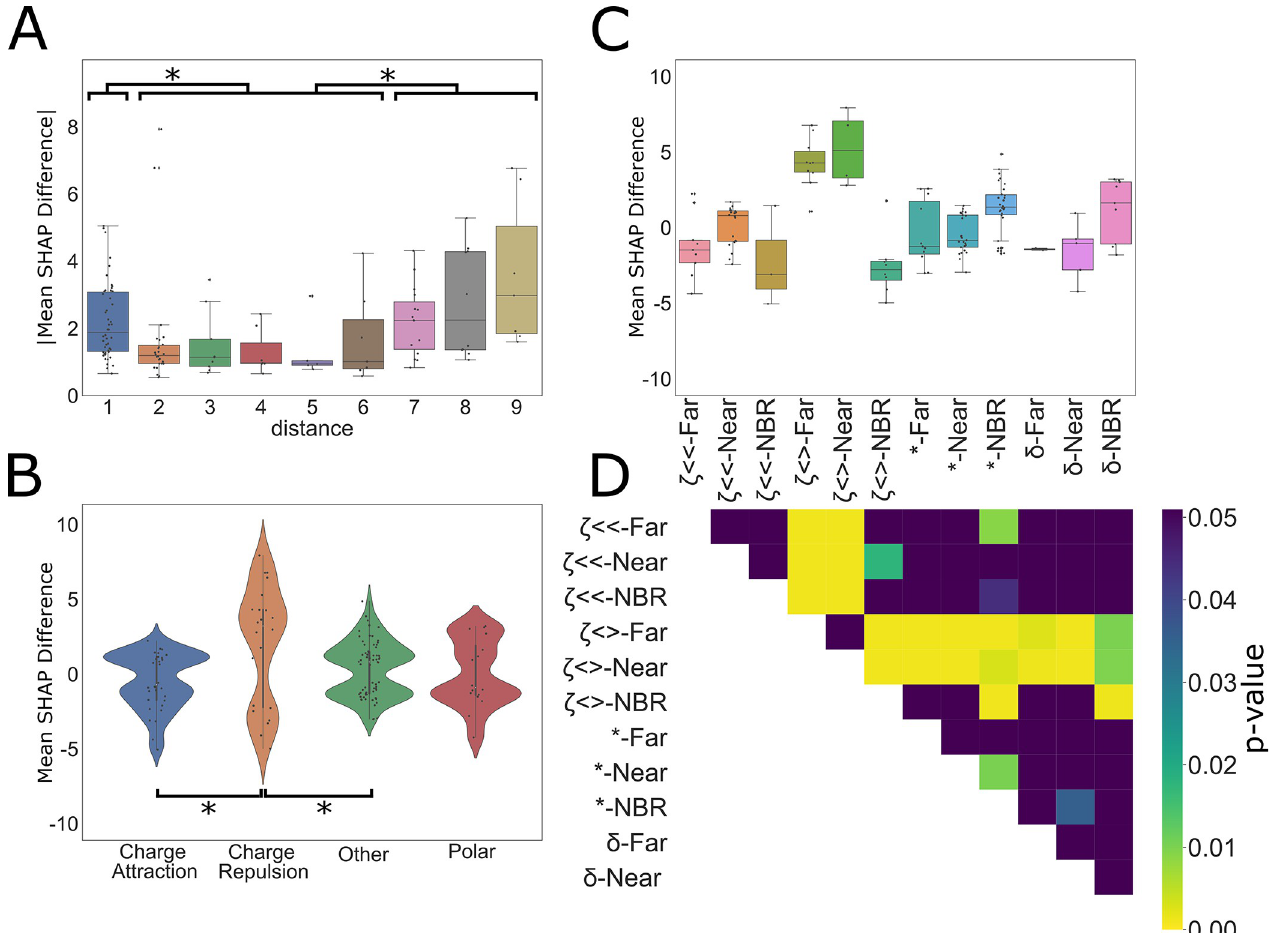
Fig 7. Dependence analysis of CCS model. (A) Significant (Bonferroni corr. P-value < 0.05) values were taken from the interpositional dependence analysis and the difference in the mean between the interdependent amino acids SHAP values and the remaining amino acids at each compared position pair were grouped based on the distance between the dependent interaction, (B) the category of interaction, or (C) distance and interaction category. Categories are labelled by the following for the combined bar plot and heatmap: z << = charge attraction, z <> = charge repulsion, � = other, and δ = polar. For the distance analysis, interactions were grouped into three categories, neighboring (distance = 1), near (distance = 2, 3, 4, 5,6), and far (distance = 7, 8, 9). � indicates significance (ANOVA with Tukey’s post hoc test p-value < 0.05). For the interaction categories in (B) and (C), each interaction was grouped by the expected type of interaction between the two amino acids. Significant differences between interaction types are noted by the pairing by lines (ANOVA with Tukey’s post hoc test p-value < 0.05). (D) Significant differences between combined categories are illustrated by the heatmap where significant values (ANOVA with Tukey’s post hoc test p-value < 0.05) are designated by colors other than purple. Exact p-values for each are provided in S4 Table. repulsive molecular interactions, including charge repulsion and “other” interactions (likely steric interactions or interactions between the termini) increased predicted CCS. Notably, there were very few significant hydrophobic interactions. This may reflect that hydrophobic interactions between amino acids in a peptide act to minimize contact with a polar solvent, rather than acting as an attractive force itself. Peptides lose polar solvent (water) during the electrospray process, which may prevent significant hydrophobic interactions, which might contradict prior work